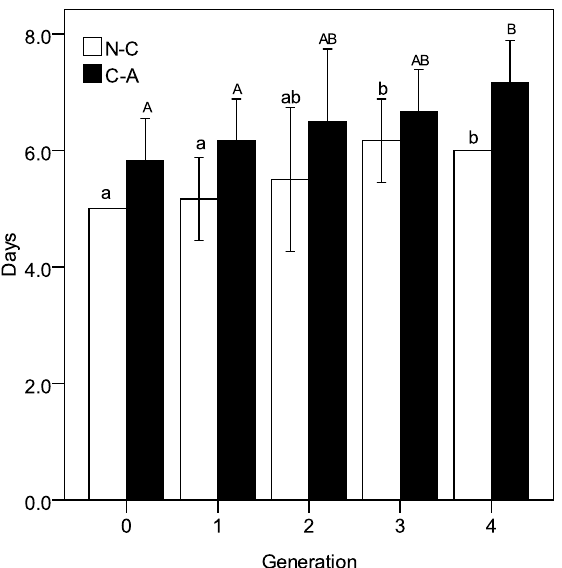
Figure 4. Effect of seawater acidification on the developmental time (mean ± standard deviation, n = 3) of larval T. japonicus in five generations (N-C developmental time of nauplii, C-A developmental time of copepodites). Successive generations were exposed to a lower pH than their parents. Statistical differences among generations ( p < 0.05) are represented by different